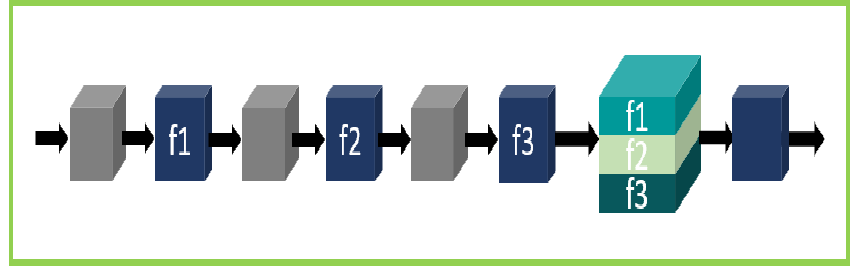
Figure 4. Seq-Residual module for our